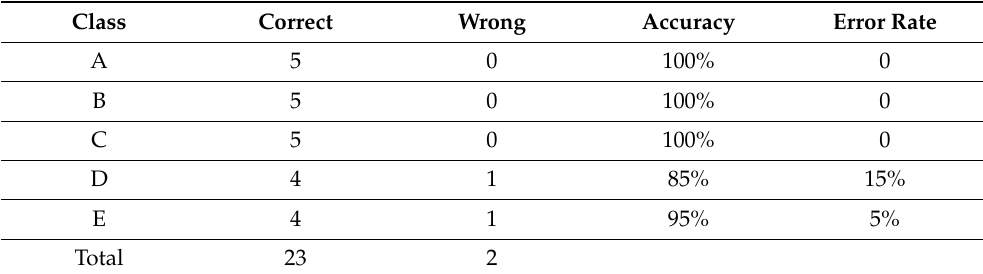
Table 4. Classified results for all classes.